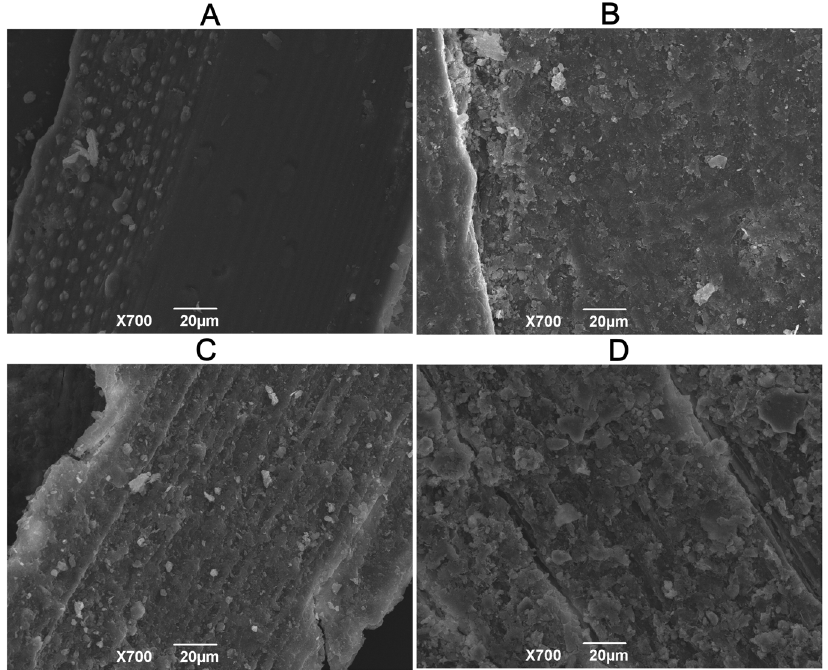
Figure 6. SEM micrographs of the rice straw residue surface on different days after incubation: A 0 d, B 15 d, C 60 d and D 110 d.